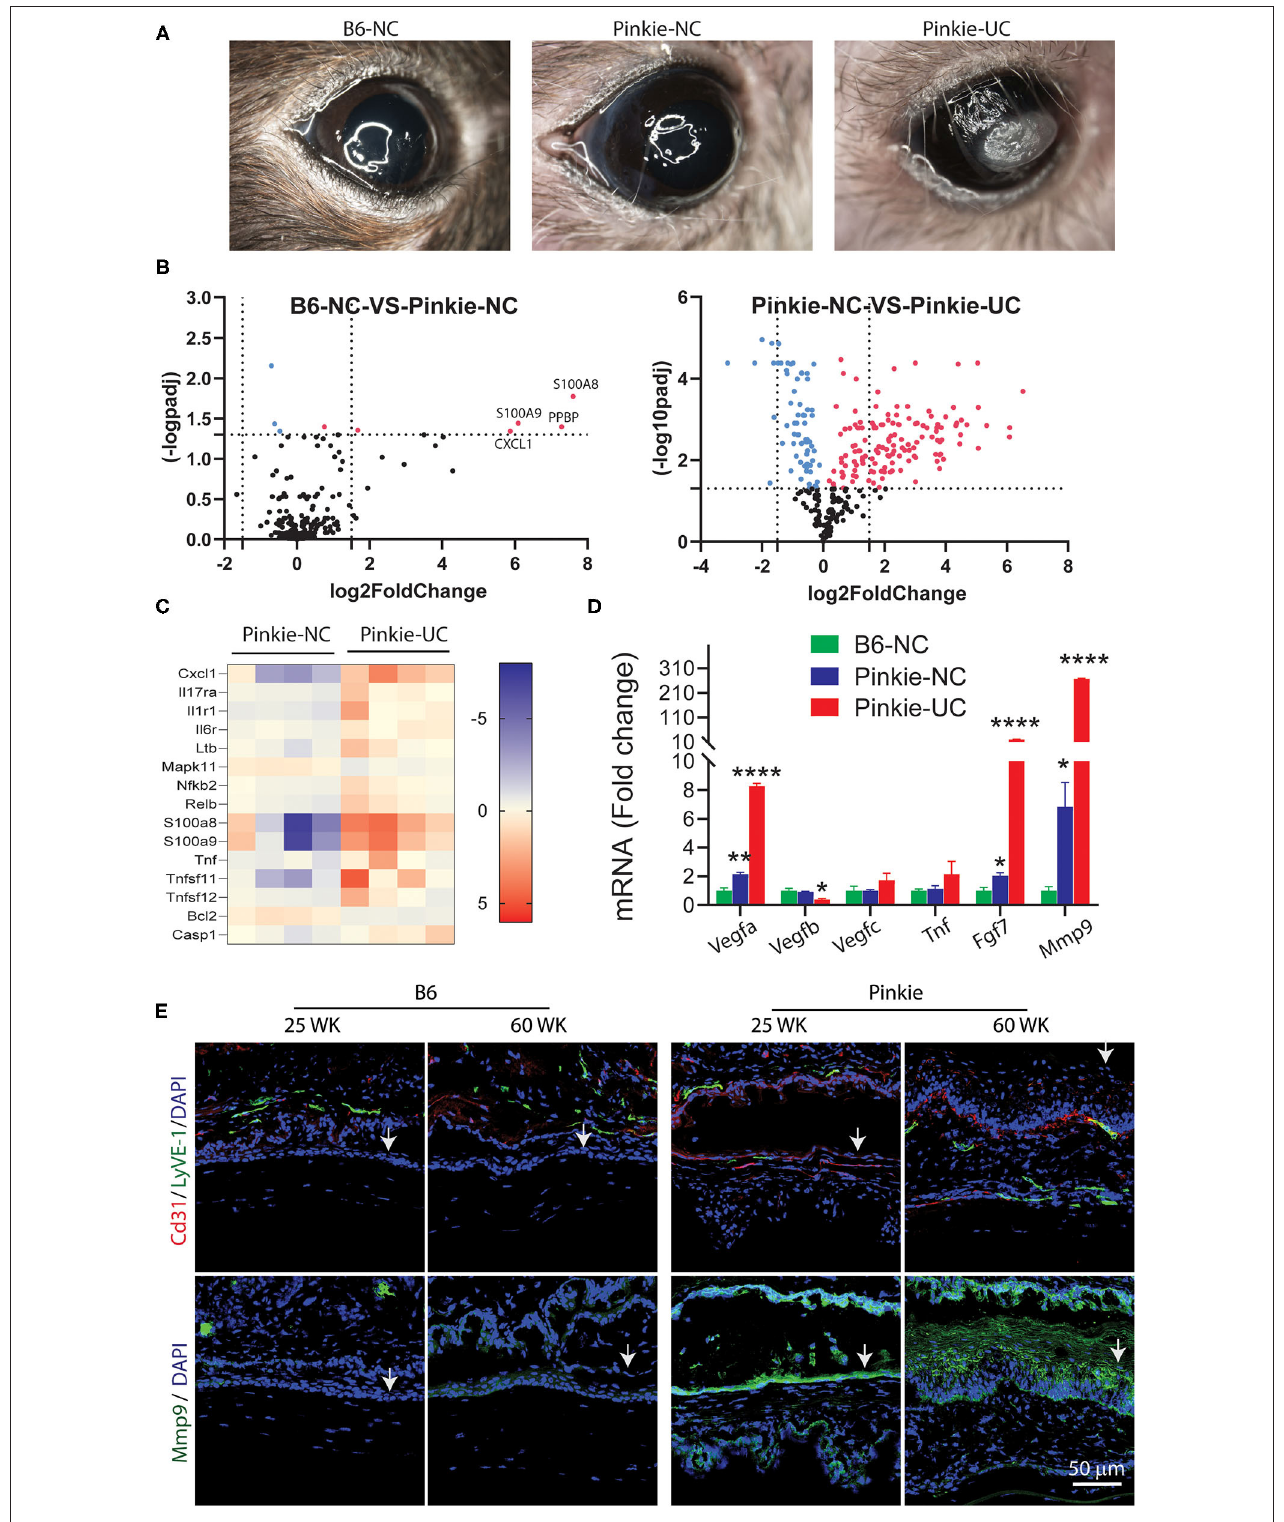
FIGURE 7 | (A) Appearance nonulcerated (NC) C57BL/6 (B6) and NC and ulcerated (UC) Pinkie corneas in 40–50-week-old mice. (B) Volcano plots of differentially expressed genes in corneas of NC B6 and Pinkie (left) and NC and UC Pinkie (right) detected by a mouse myeloid Innate Immunity Nanostring array. Dotted